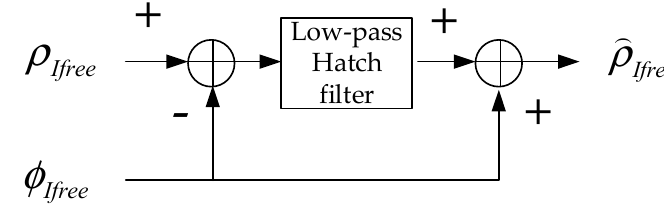
Figure 1. Block diagram of the Ifree filtering process.